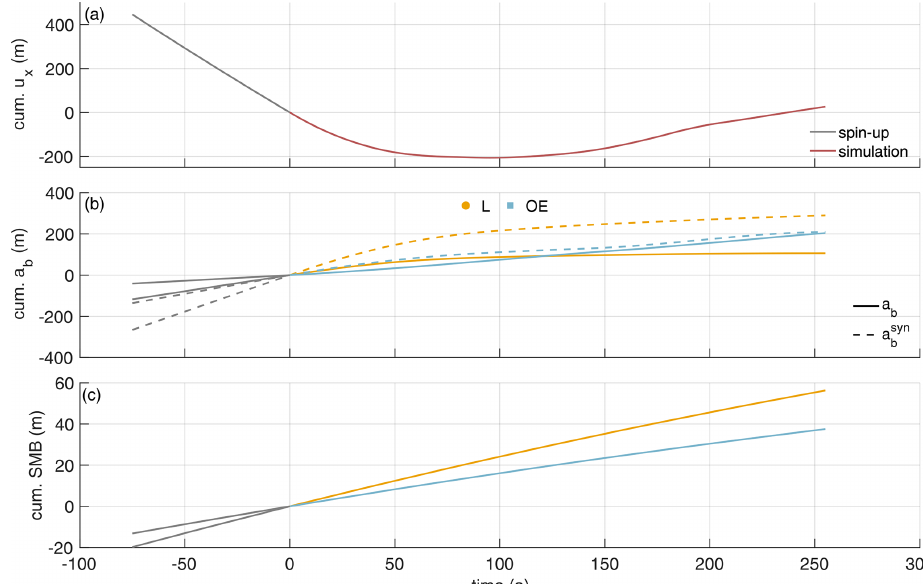
Figure B3. Model input derived from pRES measurements and RACMO (van Wessem et al., 2014). (a) Cumulative horizontal displacement of the lateral boundaries calculated from pRES-derived vertical strain rates outside of the channel. (b) Cumulative basal melt rates above (yellow) and outside the channel (blue). Solid lines are derived from the pRES measurements, and dashed lines are synthetic melt rates that are necessary to reproduce the measured ice thickness distribution. (c) Cumulative surface mass balance (SMB) derived from multi-year mean RACMO2.3 data (van Wessem et al., 2014) for a density of 910kgm − 3 outside the channel (blue) and above the channel (yellow), 50% larger. Gray lines represent values used in the spin-up and colored lines values used in the simulation of the evolution of the channel.